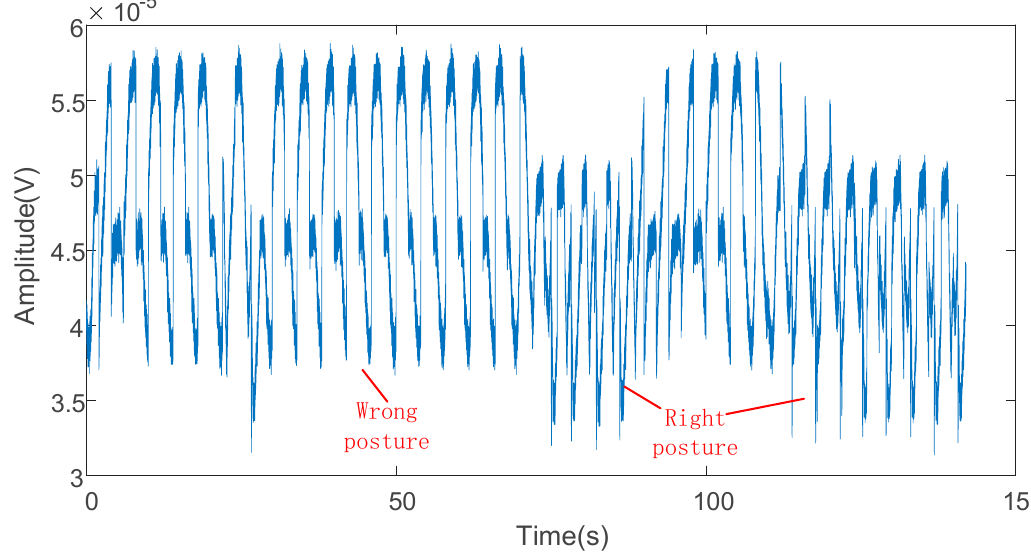
Figure 11. The envelope of the received signal.